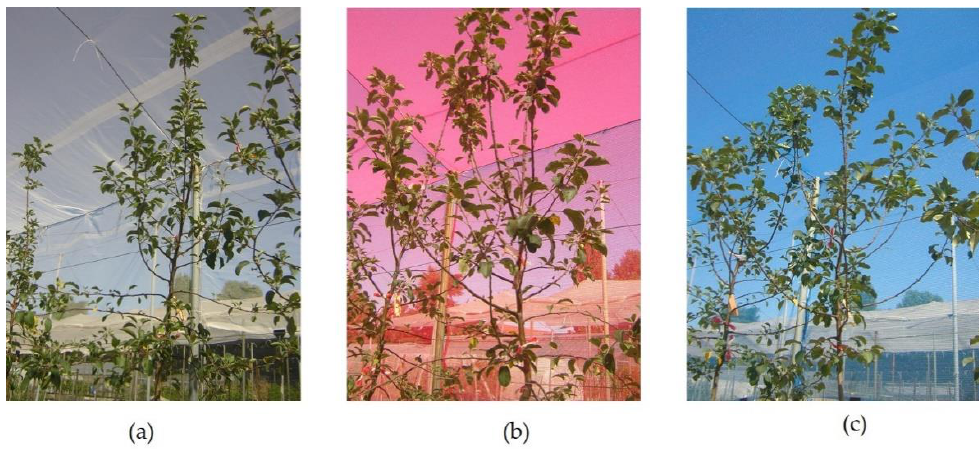
Figure 9. ( a ) Detail of ‘Fuji’ apple trees grown under white control, ( b ) red and ( c ) blue colored